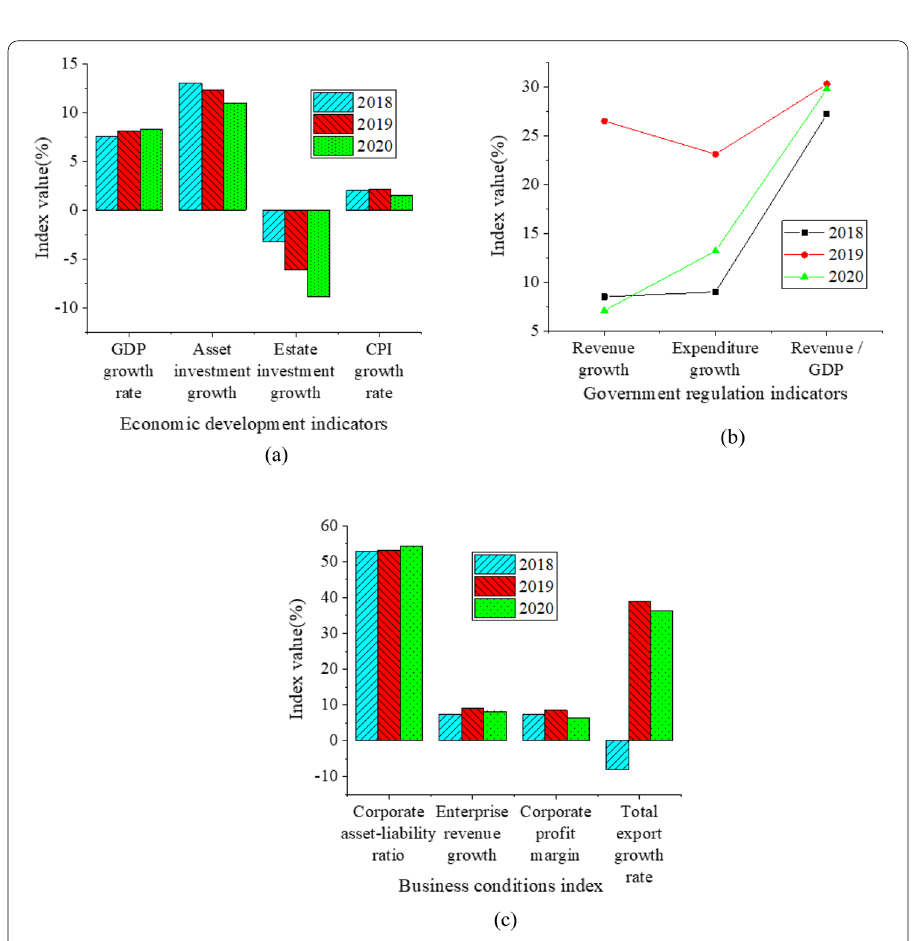
Fig. 13 Regional economic factors ( a regional economic development level indicators; b regional government regulation indicators; c enterprise operation